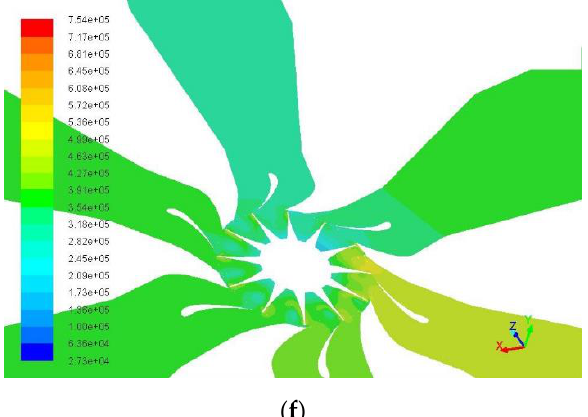
Figure 11. The plots of the total pressure monitored at the Section 1-1 during the 3rd revolution of the crankshaft for: ( a ) n = 40,000 rpm; ( b ) n = 50,000 rpm; ( c ) n = 60,000 rpm; and contours of the total pressure at the first-stage rotor during: ( d ) state A; ( e ) state B; ( f ) state C.